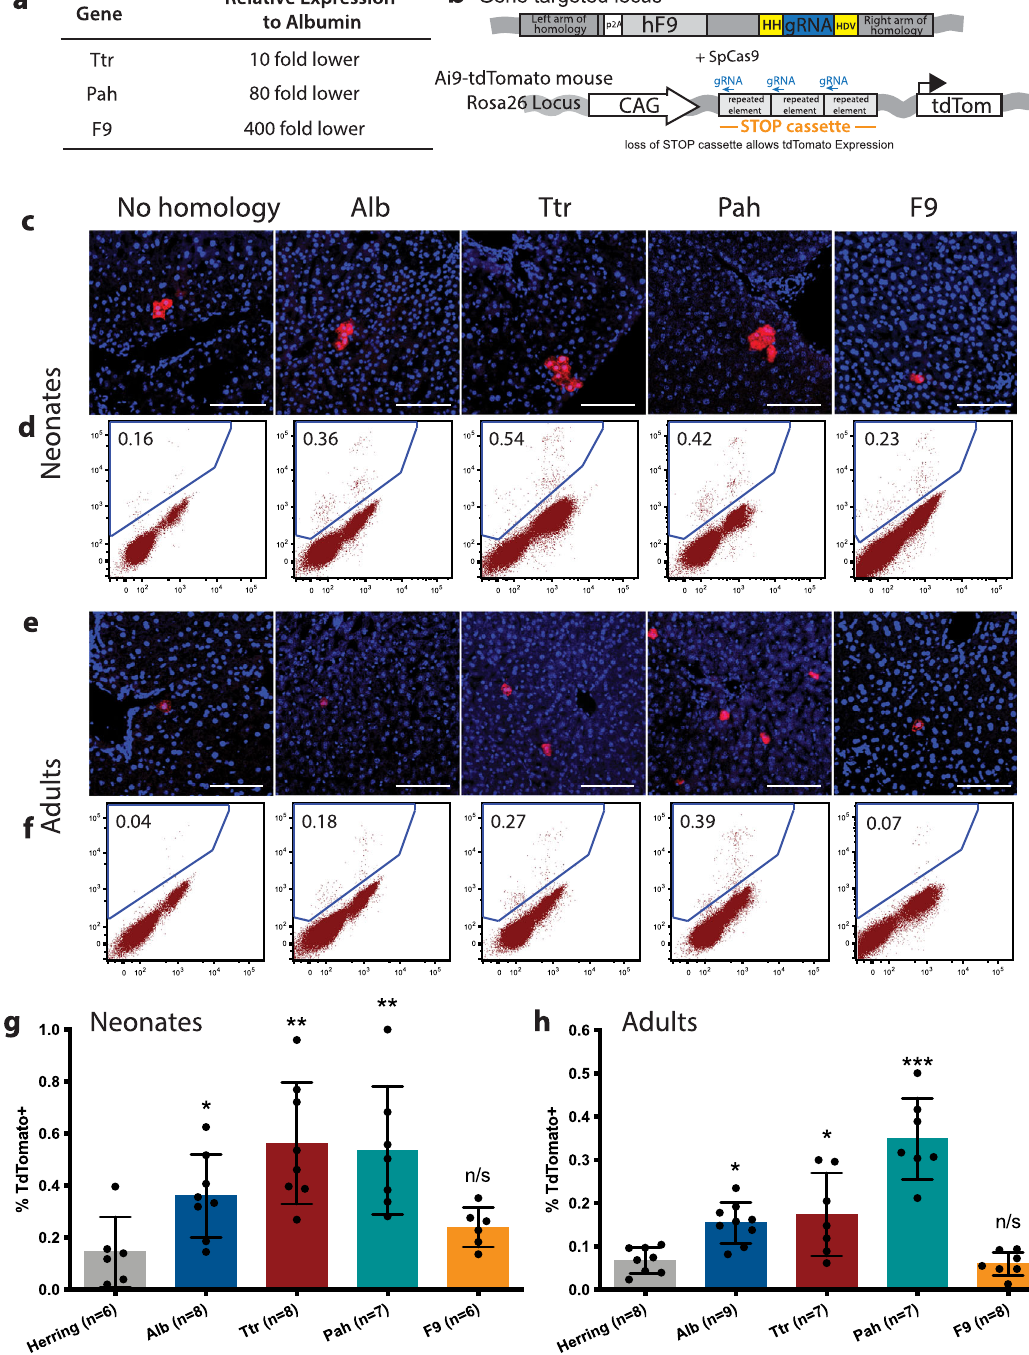
Fig. 4 | Expression of the GR-scgRNA from weaker expressing genes. a Table of weakerexpressinggenesrelativetoAlbuminwhichweretargetedwiththeGR-stop scgRNA vector. b Schematic of a gene targeted locus after homologous recombi- nation with an rAAV-GR vector containing arms of homology to one of the genes listed in (A) and a scgRNA targeting the stop cassette in the Ai9-tdTomato mouse. hF9:humanFactor9;HH:hammerheadribozyme;gRNA:guideRNAtargeting Hpd ; HDV: hepatitis delta virus ribozyme; tdTom: tdTomato. c Representative liver sections and d fl ow cytometry plots showing tdTomato positive hepatocytes in mice that received rAAV-GR targeted to the indicated locus as neonates.